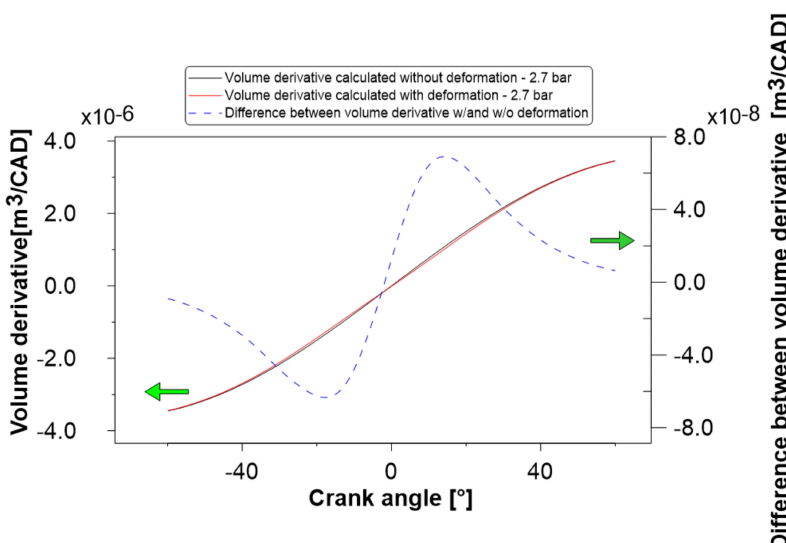
Figure 14. Volume derivative difference between the cases with and without deformation.